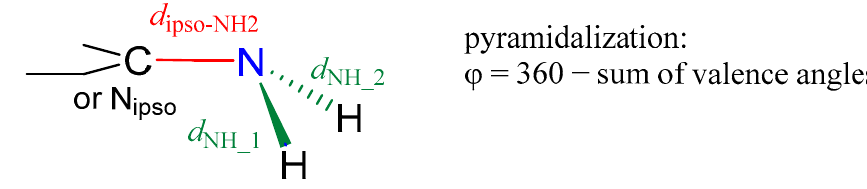
Scheme 3. Geometric parameters of the amino group.